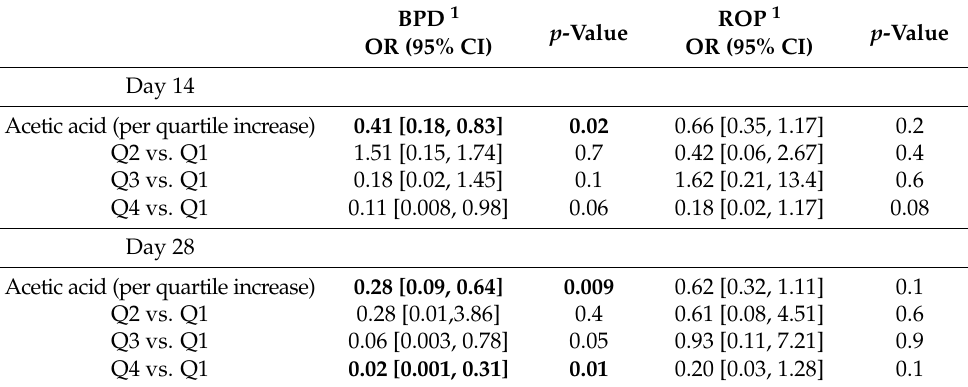
Table 5. Association of acetic acid, as quartiles, with risk of neonatal disease, BPD, and ROP 1 . BPD